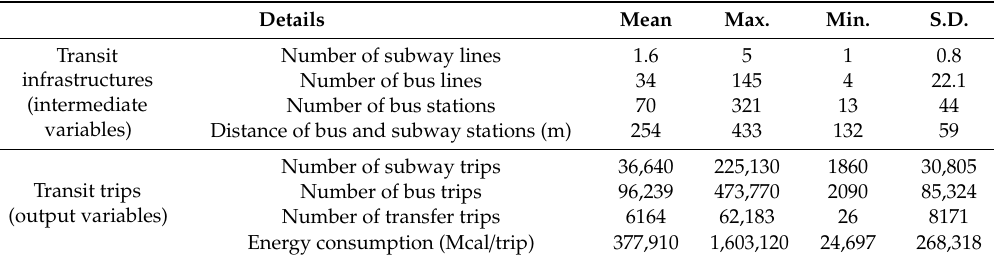
Table 3. Descriptive statistics of the transit e ffi ciency data.